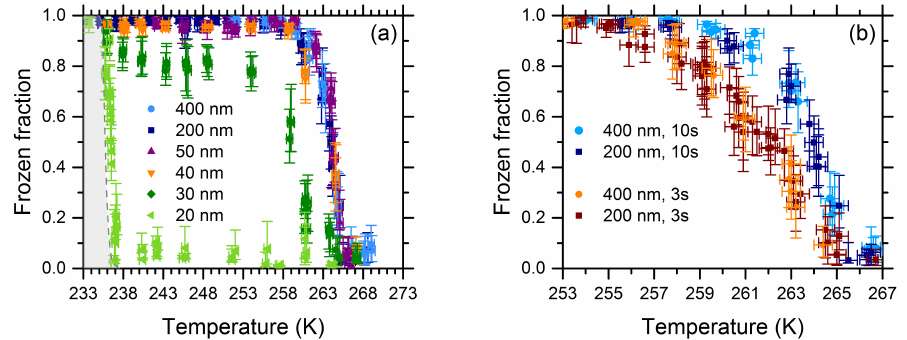
Figure 1. Immersion freezing experiments performed with the IMCA–ZINC setup. Panel (a) : particle diameter dependence of frozen fraction. The gray shaded area indicates homogeneous freezing. Panel (b) : time dependence. Note that the scales of the x axes in panels (a) and (b) are different. Error bars represent the uncertainty in the frozen fraction due to the classification (liquid or ice) uncertainty of the IODE detector (Lüönd et al.,